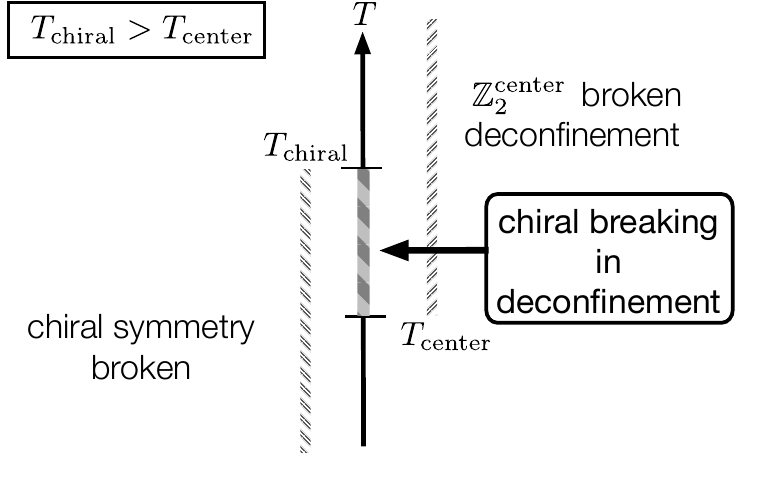
Figure 4 . The case T chiral > T center . In the range T chiral > T > T center , the chiral symmetry is broken even thougth the theory is in decon(cid:12)nement